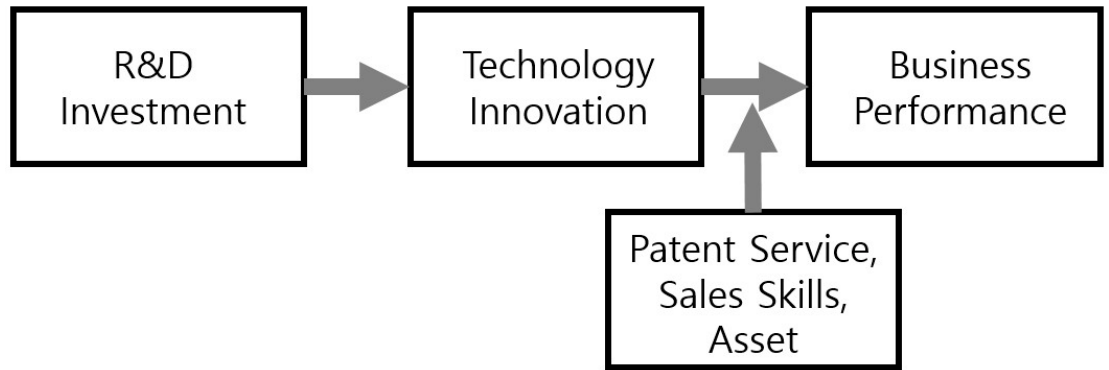
Figure 1. Process of Technology Innovation and Business Performance.